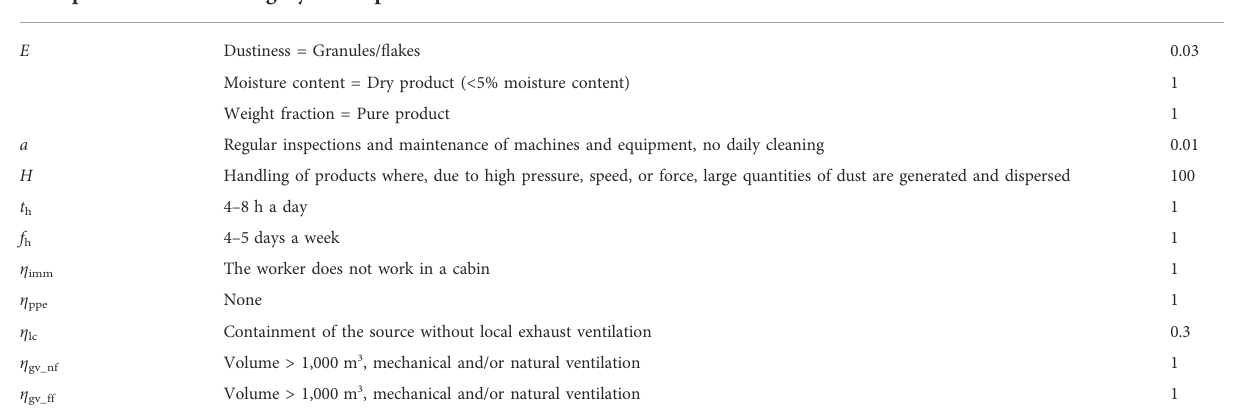
TABLE 3 The multipliers used to calculate exposure